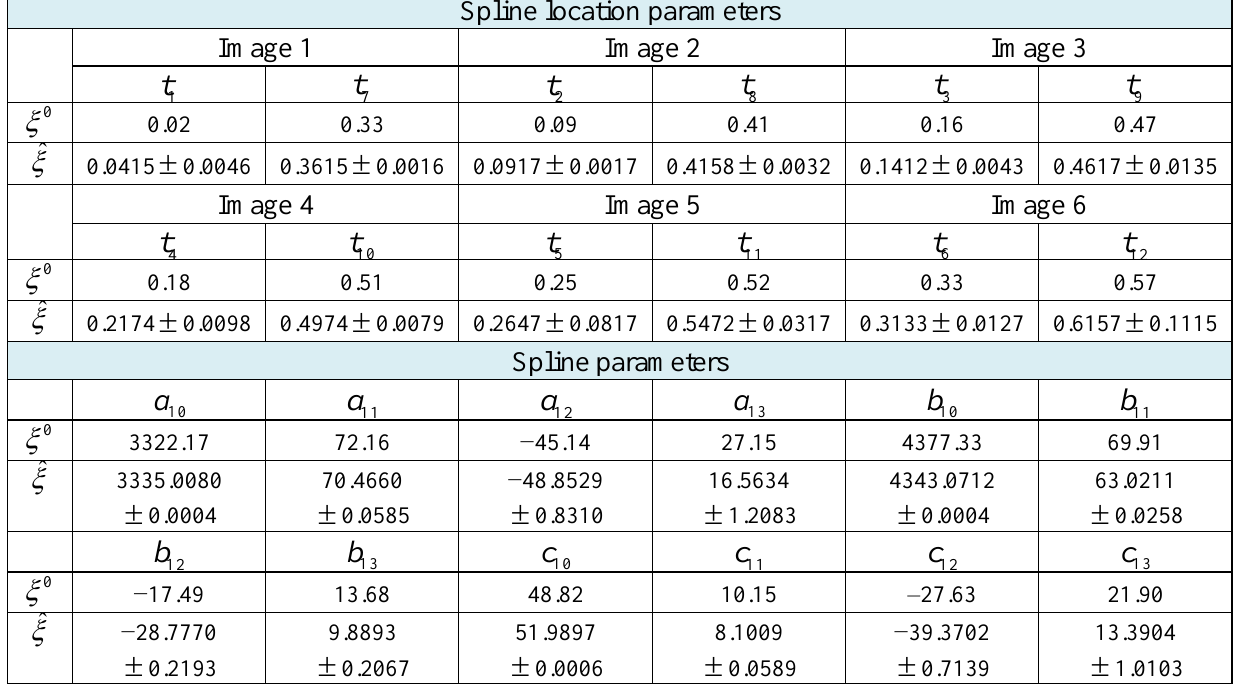
Table 3. Spline parameter and spline location parameter